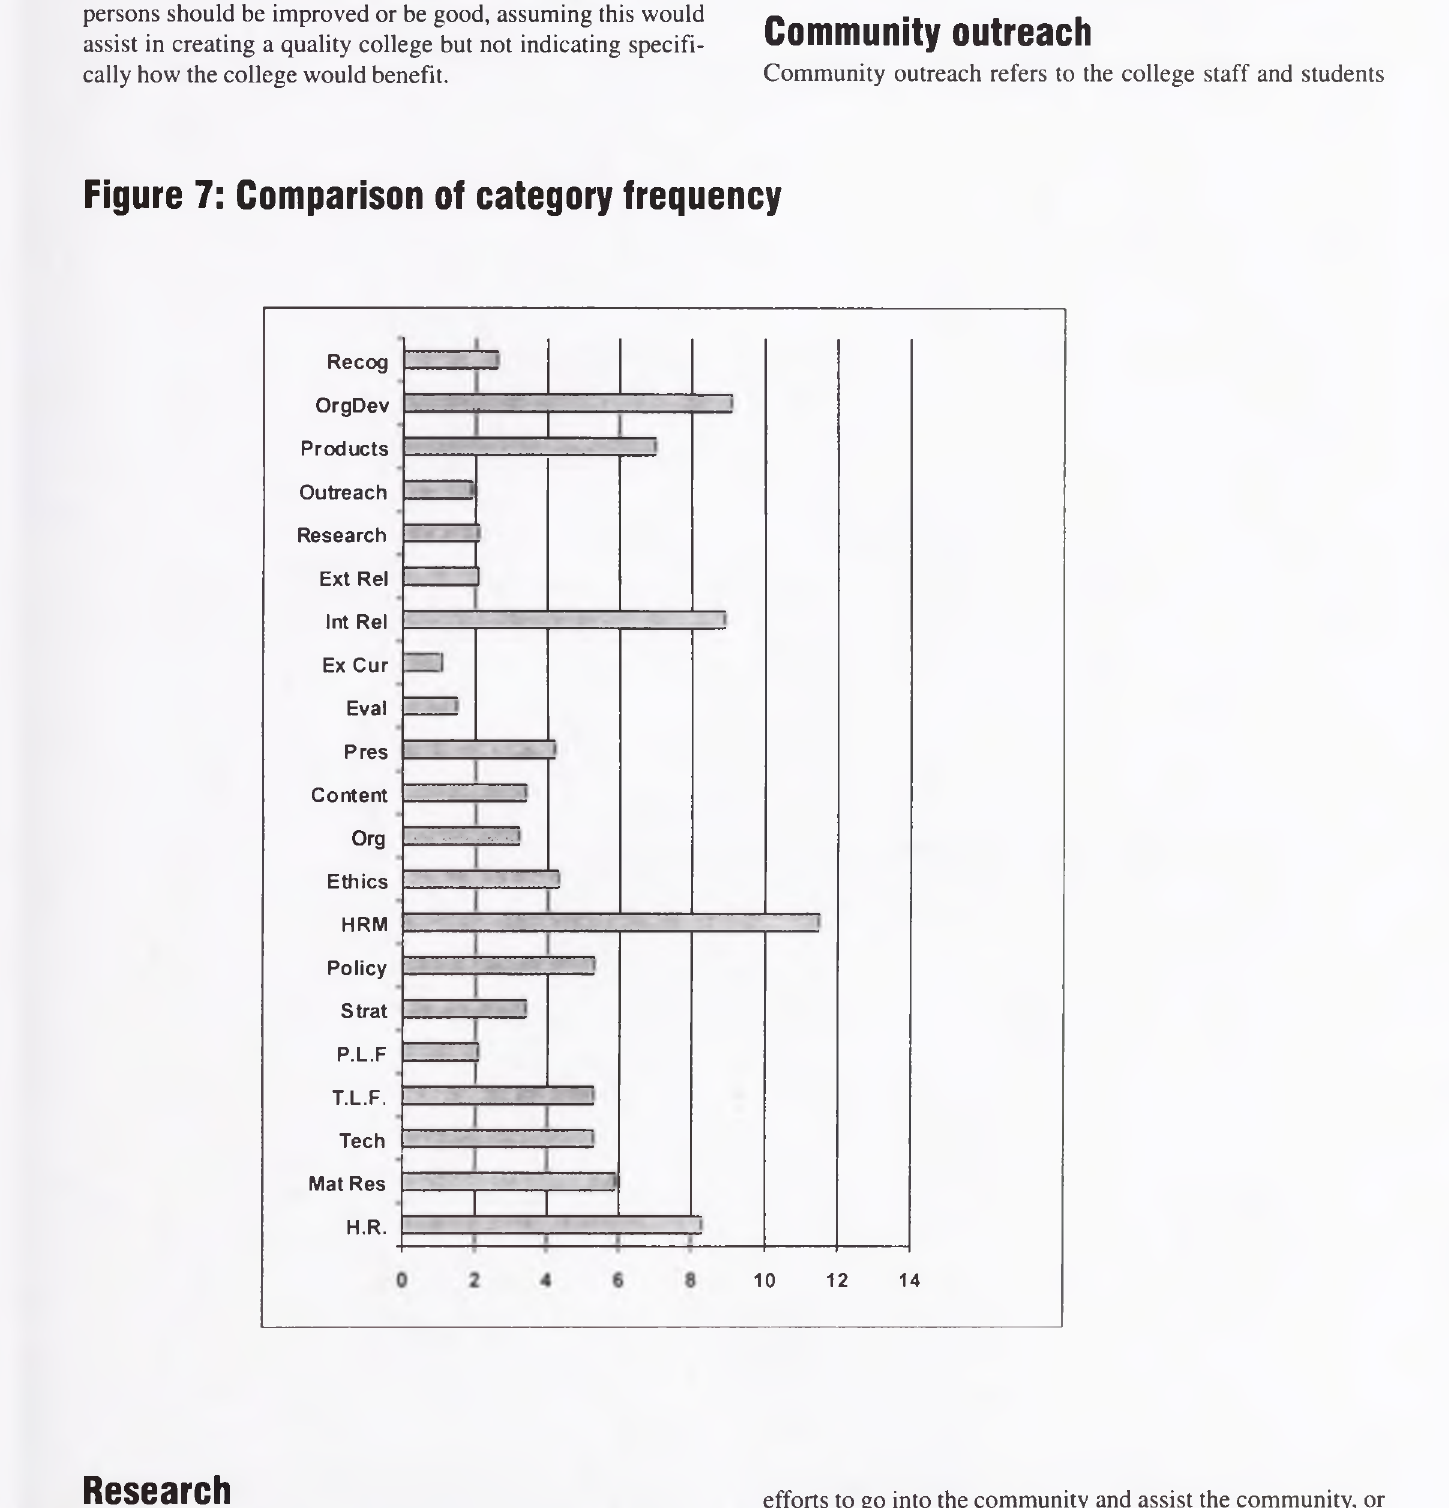
Figure 7 : Comparison of category